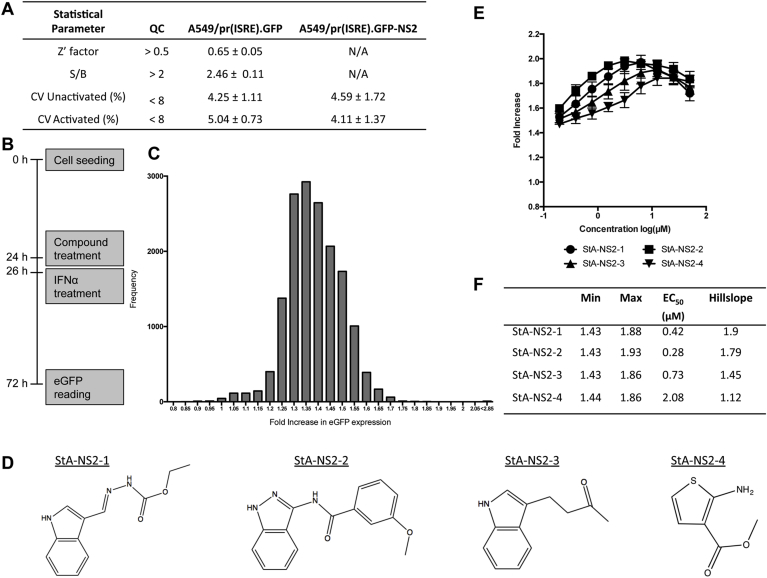
Single-point high-throughput screen to identify compounds that inhibit RSV NS2-mediated antagonism of the IFN signaling pathway. (A) Screen statistics for the A549/pr(ISRE).GFP and A549/pr(ISRE).GFP-NS2 reporter assays compared with preset quality control (QC) standards. S/B, signal-to-background ratio; CV, coefficient of variation. (B) HTS assay procedure and timing of treatments. (C) A single point HTS screen was performed using the A549/pr(ISRE).GFP-NS2 reporter cell-line and StA-HTS-Library (n = 16,000 compounds). Screen output, represented as fold increase in eGFP expression and plotted as a frequency distribution of all compounds tested. (D) Repurchased hit compound chemical structures. (E) Hit compound retesting using the A549/pr(ISRE).GFP-NS2 reporter assay and a 10-point dose-response curve (two-fold serial dilution series 50–0.1 μM). Data shown represents mean values (n = 6 replicates; error bars = SD) and is representative of at least 3 independent experiments. (F) Dose-response curve-generated EC50 (μM), maximum, minimum and Hill slope values using Prism 6 Software (GraphPad Software).